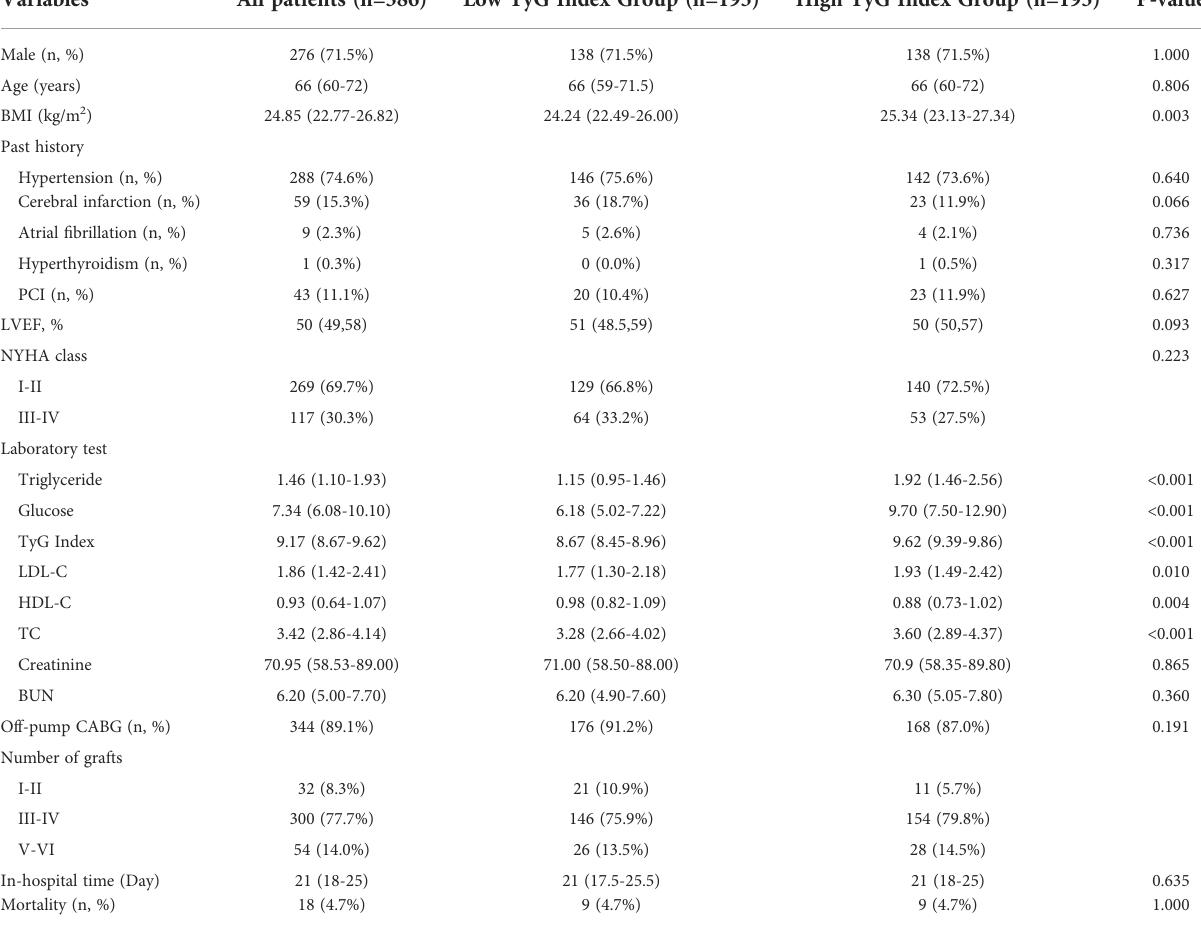
TABLE 1 Baseline characteristics in T2DM patients with CABG surgery based on tertiles of TyG Index.